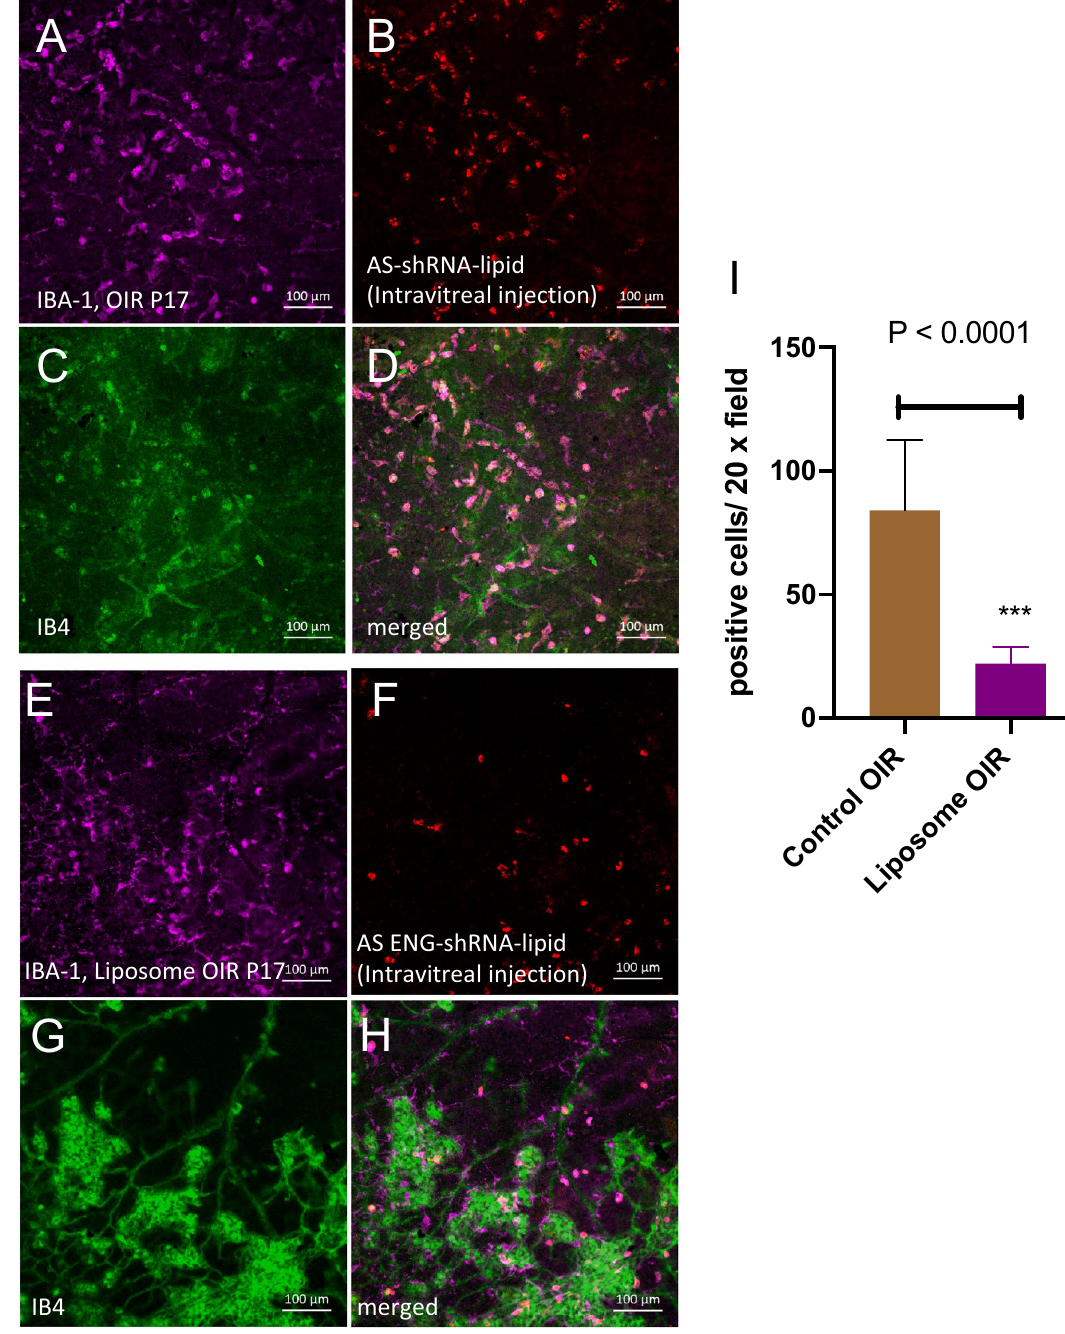
Figure 6. Depletion of microglia/macrophages using clodronate-liposome in mouse OIR reduces the AS-Eng shRNA–lipid derived fluorescence in the retinas compared to control PBS-injected OIR retinas. AS-Eng shRNA–lipid derived fluorescence was monitored in mice with intraocular injection of AS-Eng shRNA– lipid. IBA1 was used to visualize the microglia/macrophages in the retina and IB4 was used to visualize the vasculatures. ( A – D ) A large number of IBA1 positive microglial/macrophages were observed in the control PBS-liposome injected OIR retinas that were also positive for AS-Eng shRNA–lipid derived fluorescence. ( E – H ) However, number of AS-Eng shRNA–lipid positive cells was decreased significantly in the clodronate-liposome injected retinas ( B vs F ) as shown in l (n = 9 each sample group). Scale bar 100